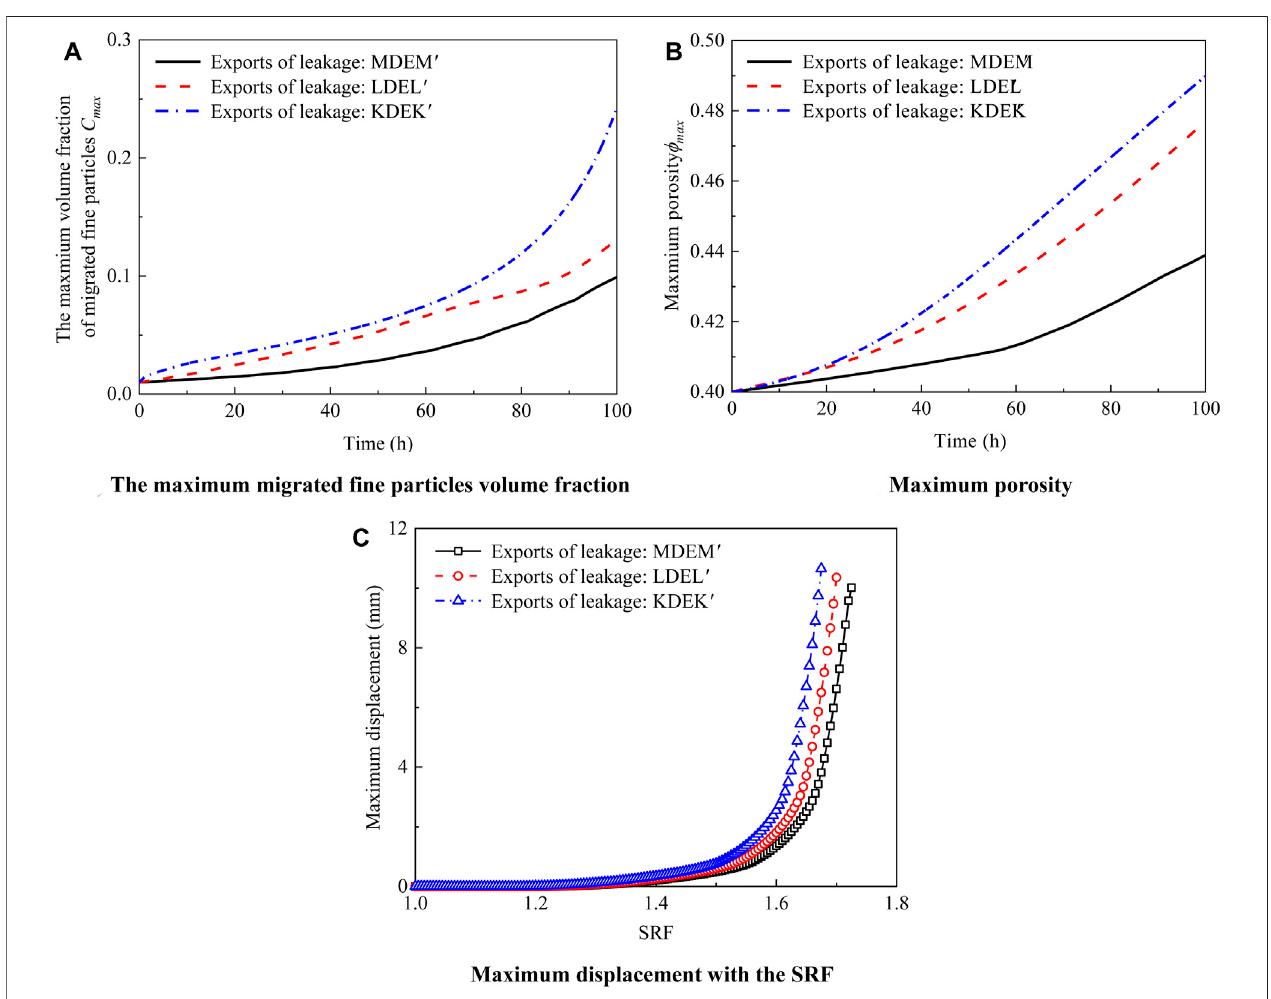
FIGURE 14 | The in fl uence of downstream leakage outlets on the maximum migrated fi ne particles volume fraction, maximum porosity, and maximum displacement. (A) The maximum migrated fi ne particles volume fraction. (B) Maximum porosity. (C) Maximum displacement with the SRF.